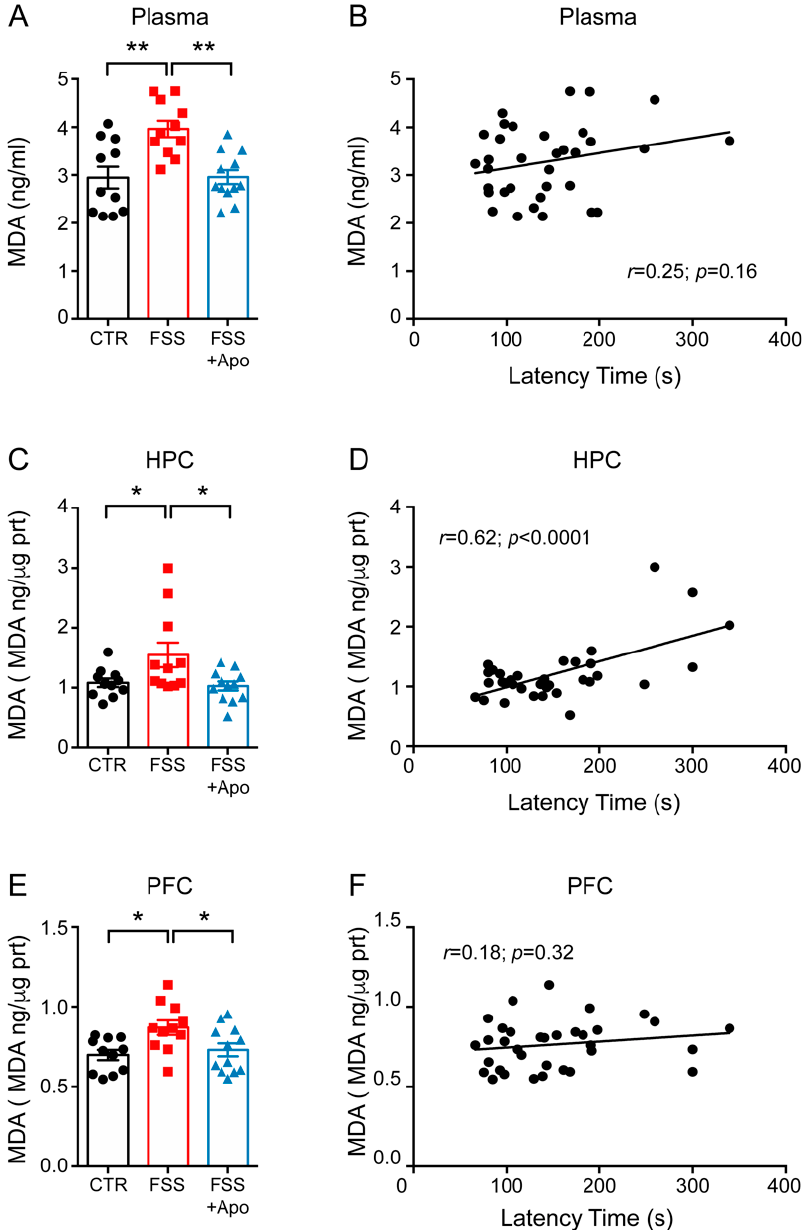
Figure 2. Apocynin prevents the FSS ‐ induced increase of lipid peroxidation. ( A , C , E ) MDA levels measured in the plasma ( A ), hippocamps (HPC) ( C ) and prefrontal cortex (PFC) ( E ). One ‐ way ANOVA followed by Tukey’s post hoc analysis. Data are presented as mean ± SEM ( n = 11–12 mice/group). ( B , D , F ) Linear correlation between the latency to feed and the MDA levels in the plasma ( B ), HPC ( D ) and PFC ( F ). Pearson’s correlations ( n = 11–12 mice/group). * p < 0.05; ** p < 0.01.